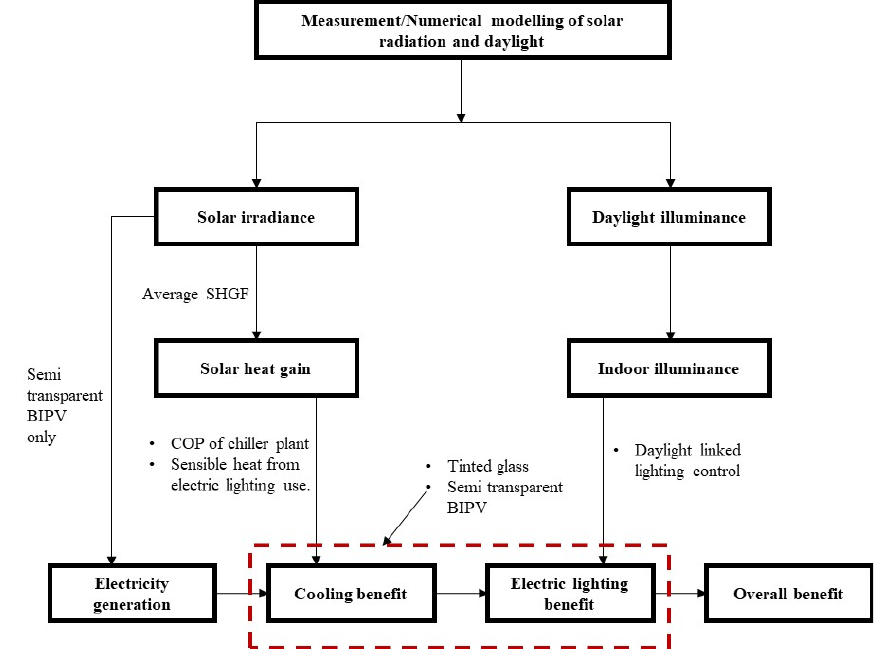
Figure 2. Flow chart of energy-evaluation method .